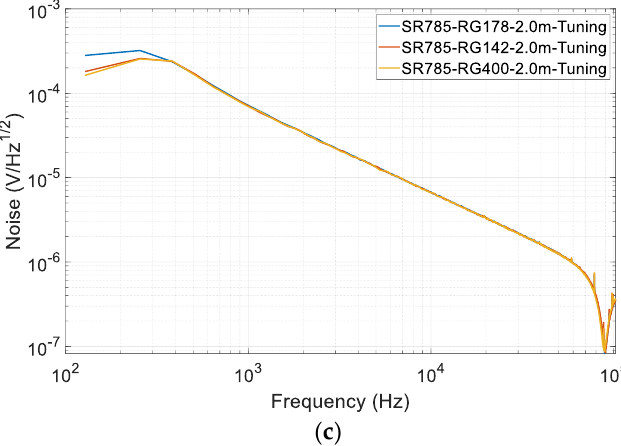
Figure 7. The measured output voltage noise curve of the preamplifier after the tuning under different lengths of the cables: ( a ) using the 0.5-m-long cable; ( b ) using the 1.0-m-long cable; ( c ) using the 2-m-long cable.